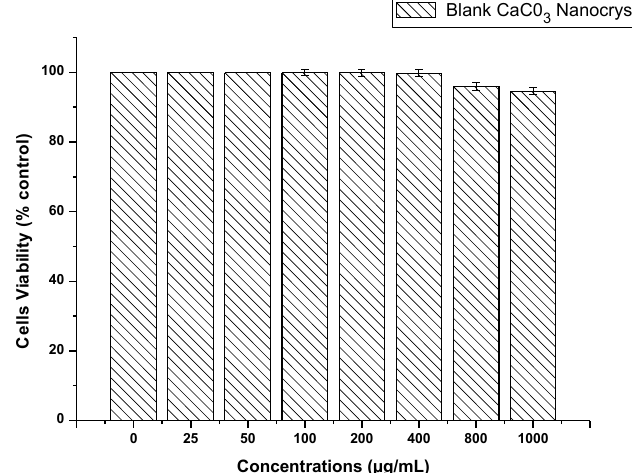
on MG 63 bone cancer cells 3